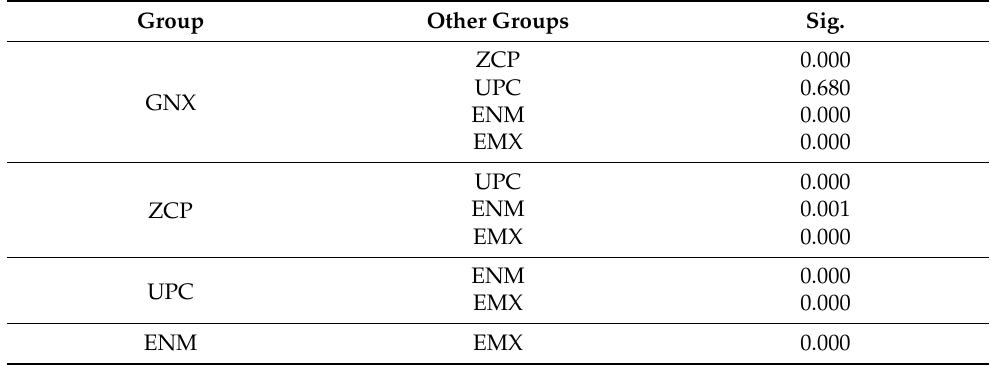
Table 13. Multiple comparisons between OP values for the aged groups. Shaded cells indicate significant differences p < 0.5.